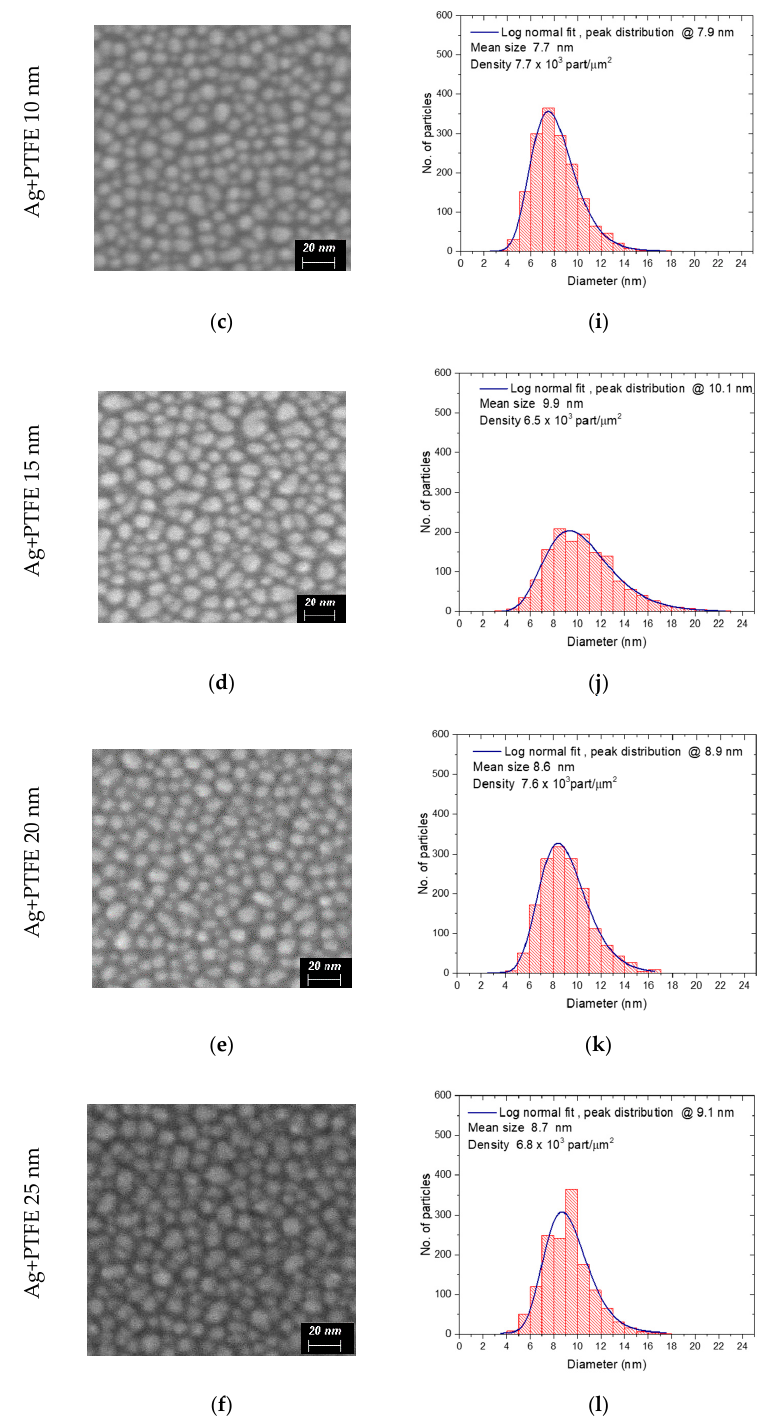
Figure 7. ( a – f ) HR-SEM images of the Ag-PTFE nanocomposites with various thicknesses of the top layer; ( g – l ) size distribution of the nanoparticles (NP) observed in HR -SEM images.